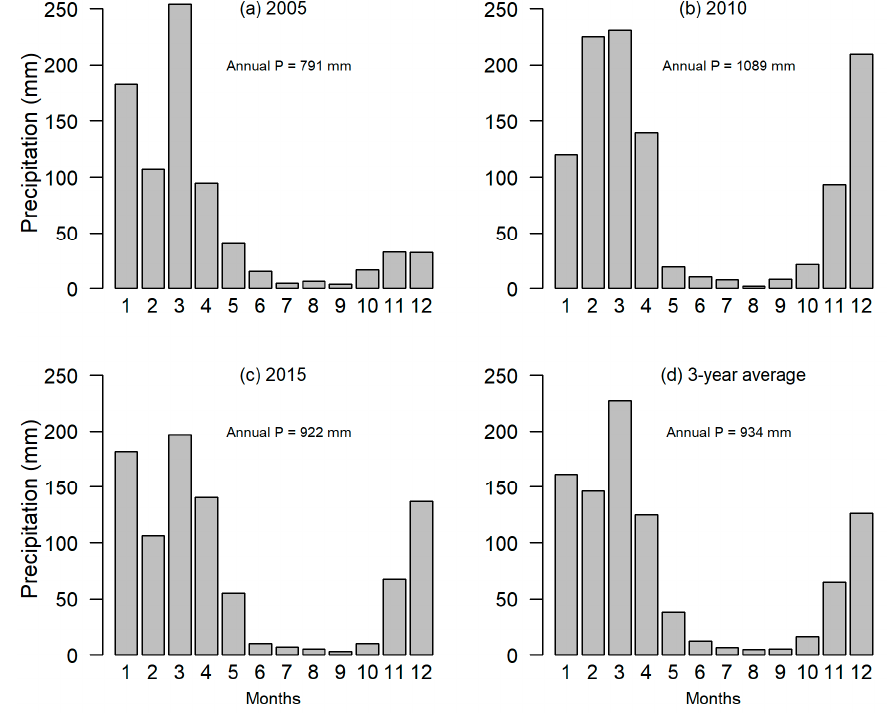
Figure 2. The monthly average precipitation over the Kilombero Valley (KV) river basin based on the arithmetic mean of five precipitation stations. ( a ) Monthly average precipitation in 2005, ( b ) Monthly average precipitation in 2010, ( c ) Monthly average precipitation in 2015, and ( d ) Monthly average precipitation for all three years (i.e., 2005, 2010, and 2015).